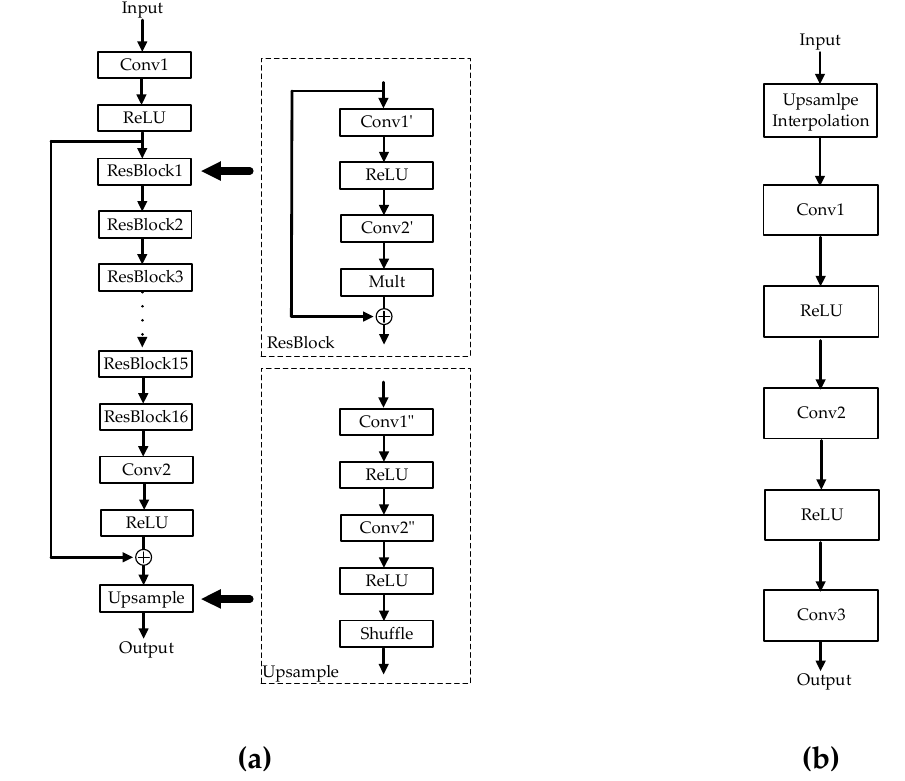
Figure 3. The architecture of the deep residual CNN and 3-layer CNN. ( a ) Deep residual CNN; ( b ) 3-layer CNN.